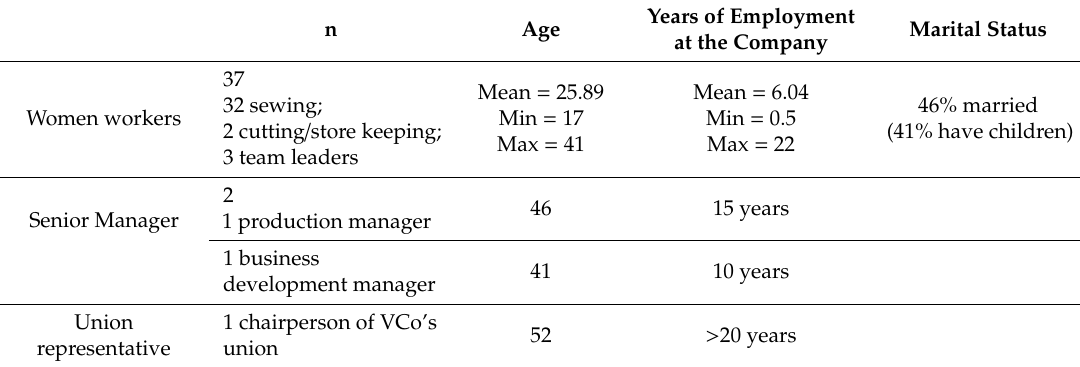
Table 2. Summary of the interview sample.